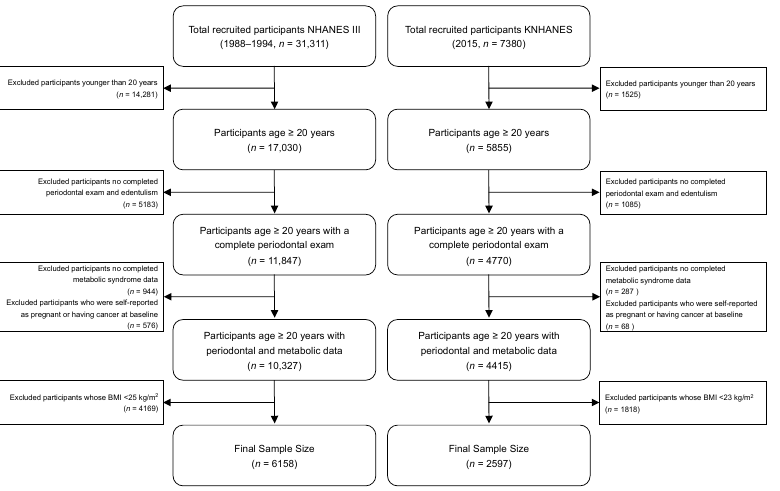
Figure 1. Flow chart of final sample from The Third National Health and Nutrition Examination Survey (NHANES III) and Korean National Health and Nutrition Examination Survey (KNHANES).